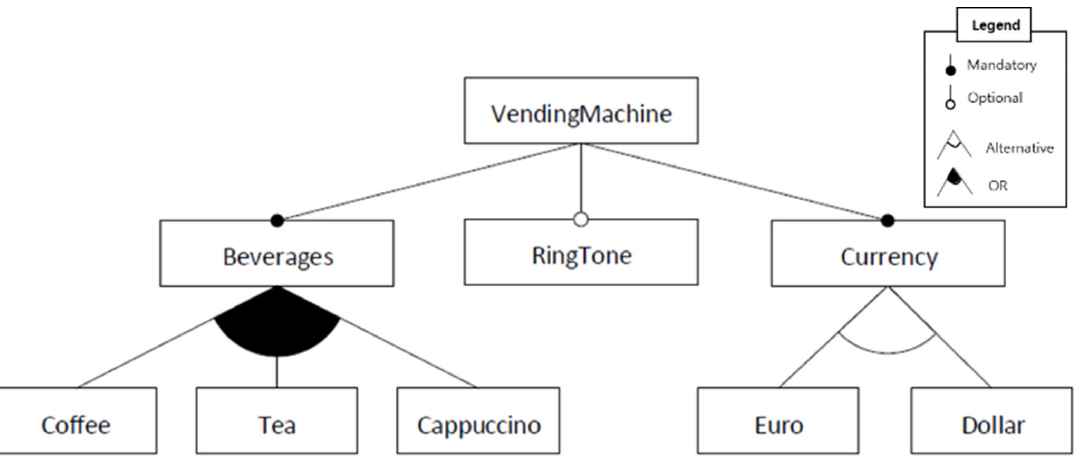
Figure 3. The feature model for SPL V0 . Table 2. Test cases for SPL V0 .